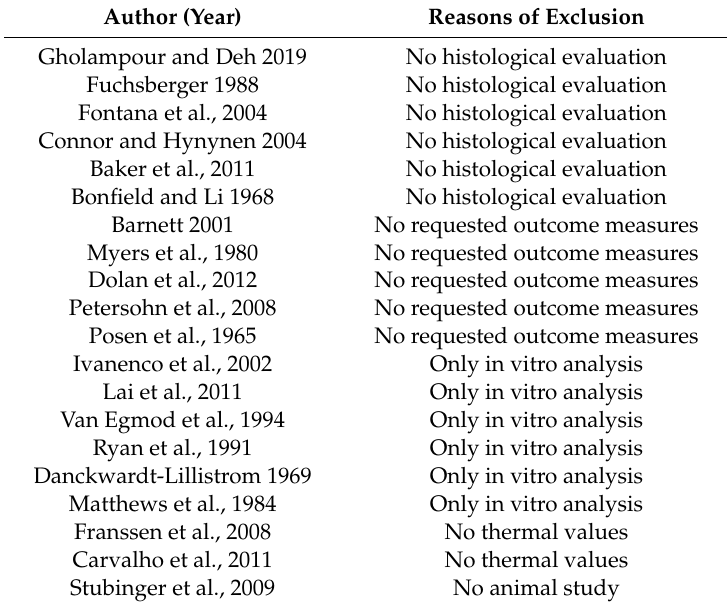
Table 1. Studies excluded after full-text